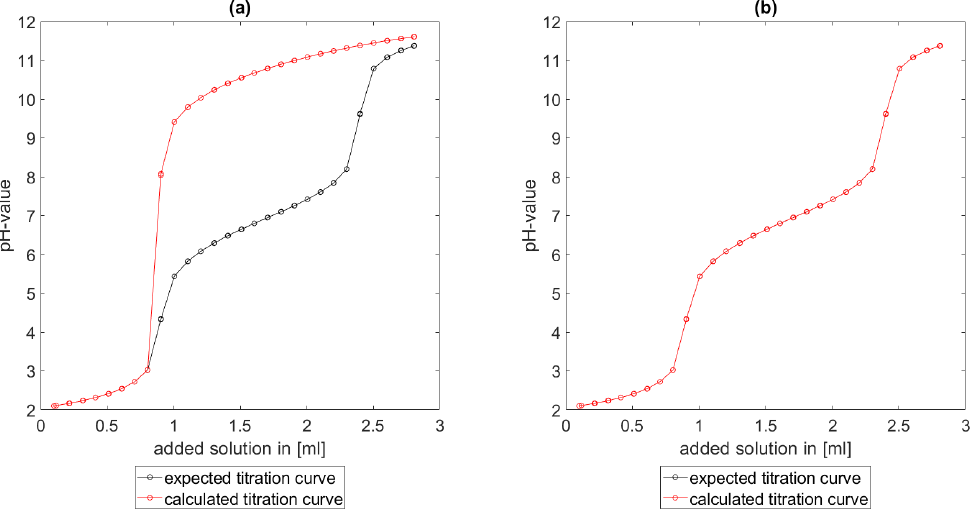
Figure 7. ( a ) Comparison of original titration curve and calculated titration curves with initial stability constants defined in Table 5. ( b ) Comparison of titration curves with optimized and original stability constants. Numeric results are in Table